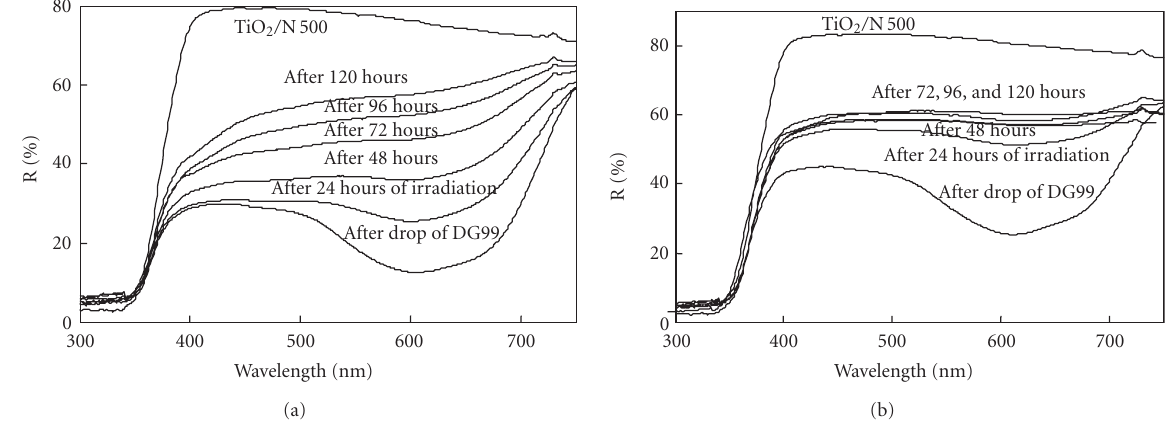
Figure 8: The UV-VIS/DR spectra of TiO 2 /N 500 catalyst placed on the glass plate after sandblasting (a) without liquid glass layer and (b) with liquid glass